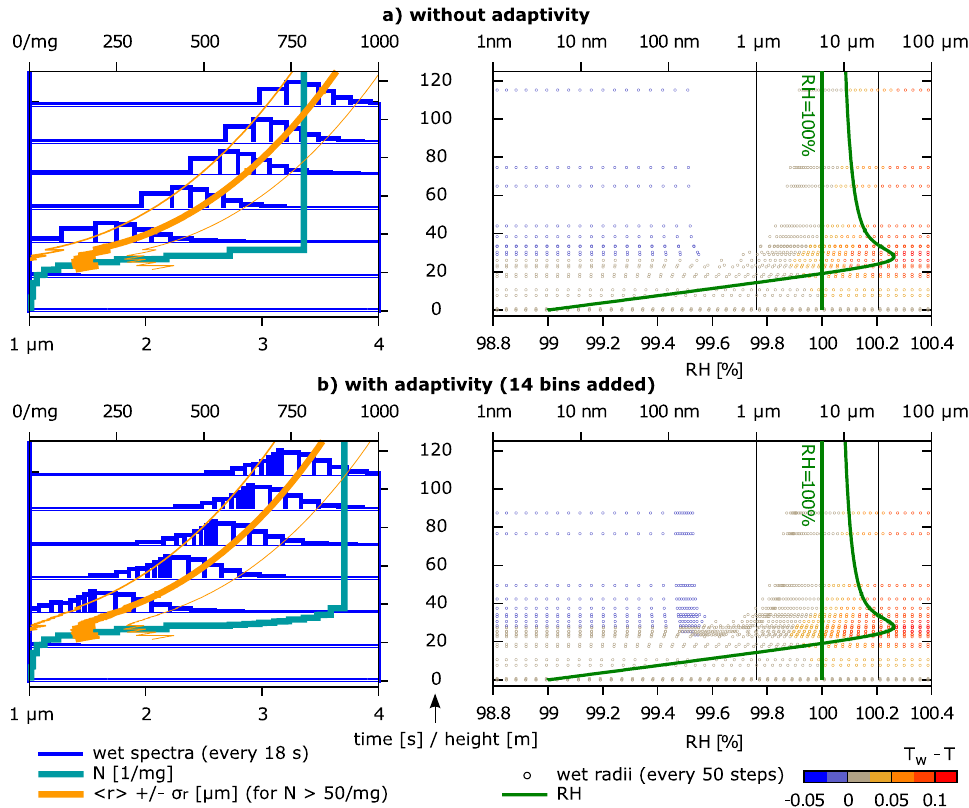
Fig. 7. A comparison of aerosol spectra evolution as calculated in two model runs with adaptivity toggled off (a) and on (b) . See captions of Figs. 1–3 for description of the plot elements. Figure discussed in Sect.